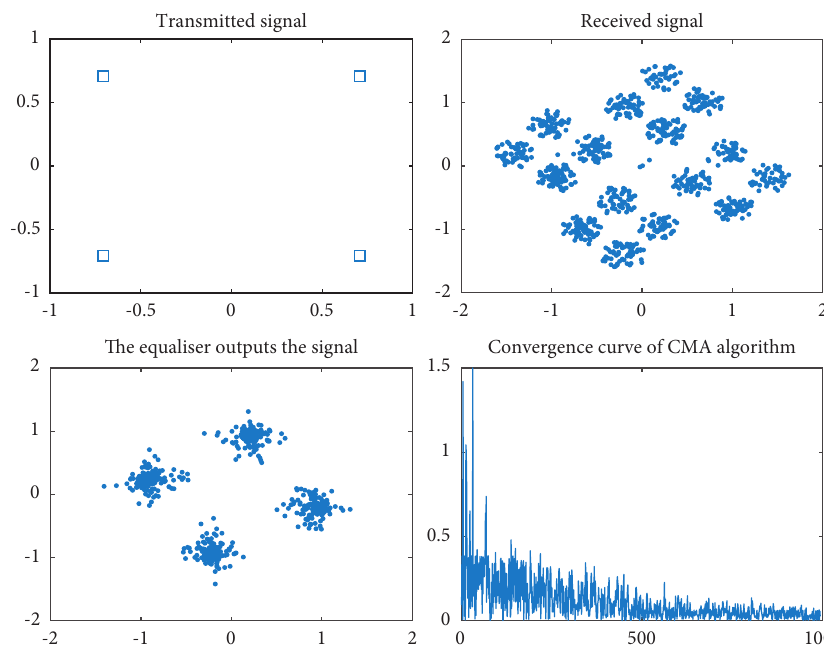
Figure 2: Equalisation effect of the CMA.